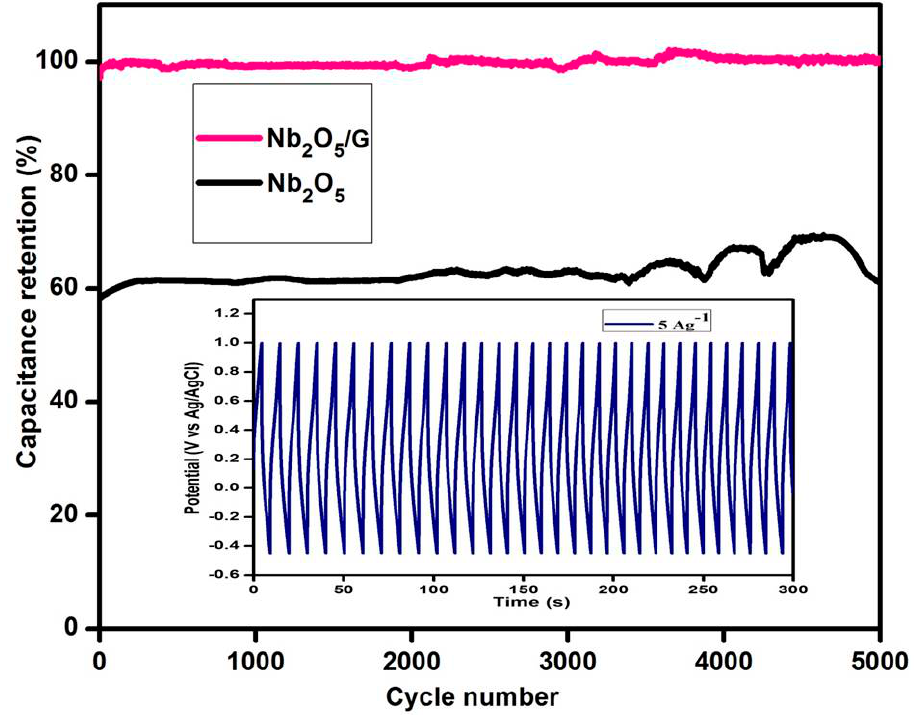
Figure 12. Capacitance retention of Nb 2 O 5 / G composite electrode upto 5000 cycles at a current density of 5 Ag − 1 with an inset for a few cycles.